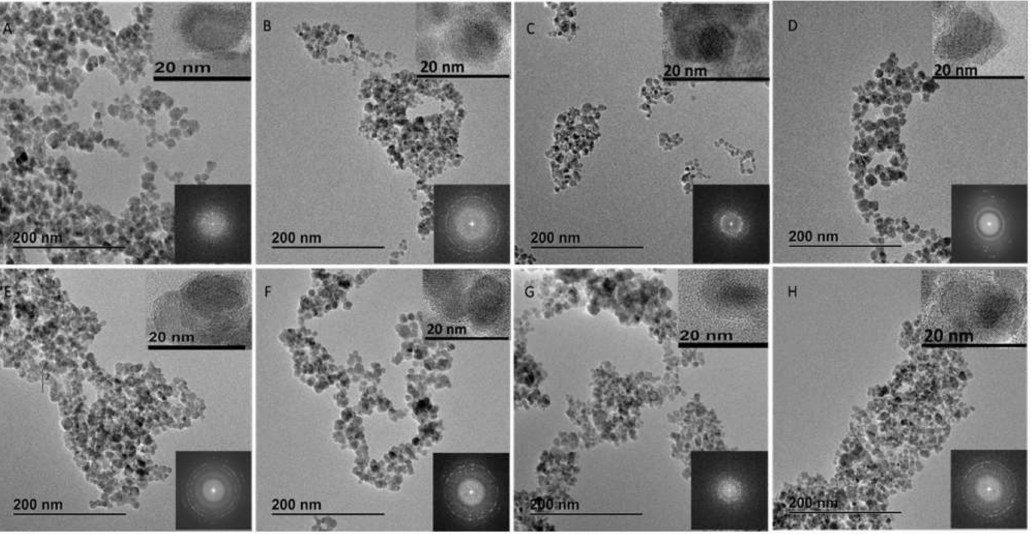
Figure 2. Transmission electron microscopy (TEM) images, size distribution and selected area electron di ff raction (SAED) of ( A ) mag@zcf 1 , ( B ) zcf@mag 2 , ( C ) zcf@mag 1 , ( D ) mag@zcf 2 , ( E ) mag@cf 1 , ( F ) mag@cf 2 , ( G ) cf@mag 1 and ( H ) cf@mag 2